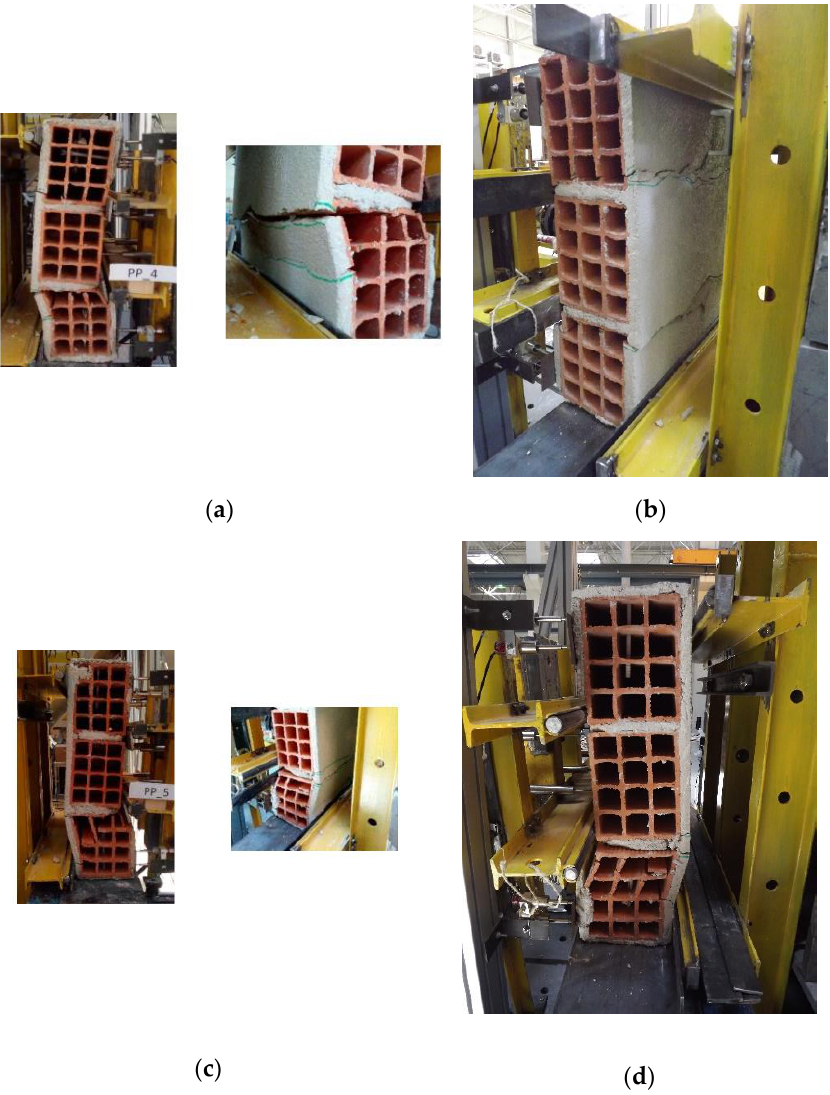
Figure 7. Damages observed: ( a , b ) Specimen 4 and ( c , d ) Specimen 5.